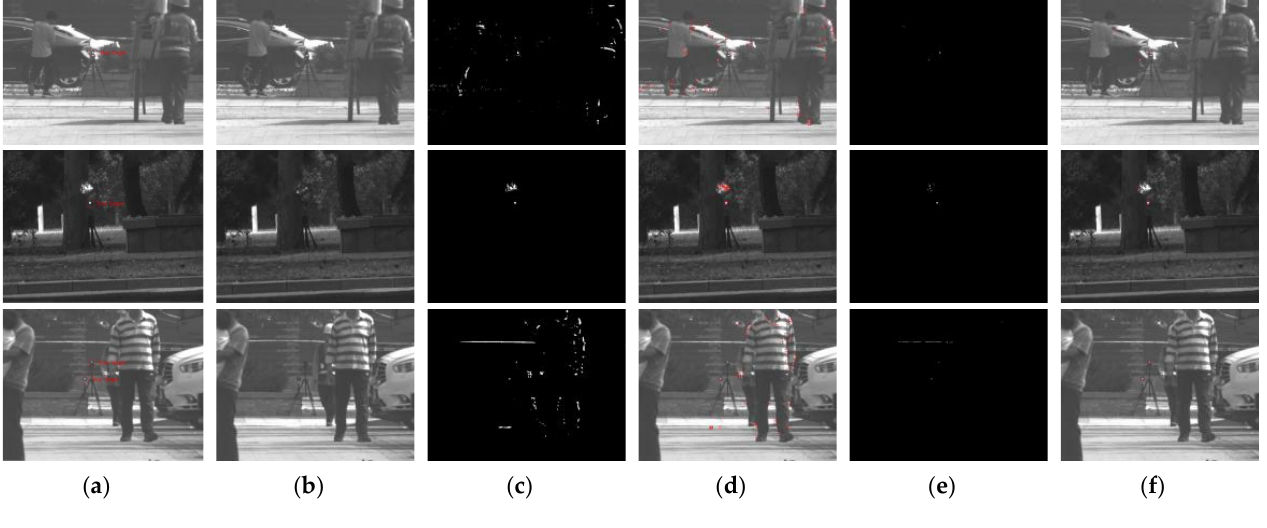
Figure 11. Comparison of the number of candidate regions produced by different threshold segmentation methods: ( a ) active image, ( b ) passive image, ( c ) Otsu-based segmentation, ( d ) candidate area segmentation based on the Otsu threshold, ( e ) proposed threshold segmentation effect, ( f ) candidate area segmentation based on the proposed threshold.